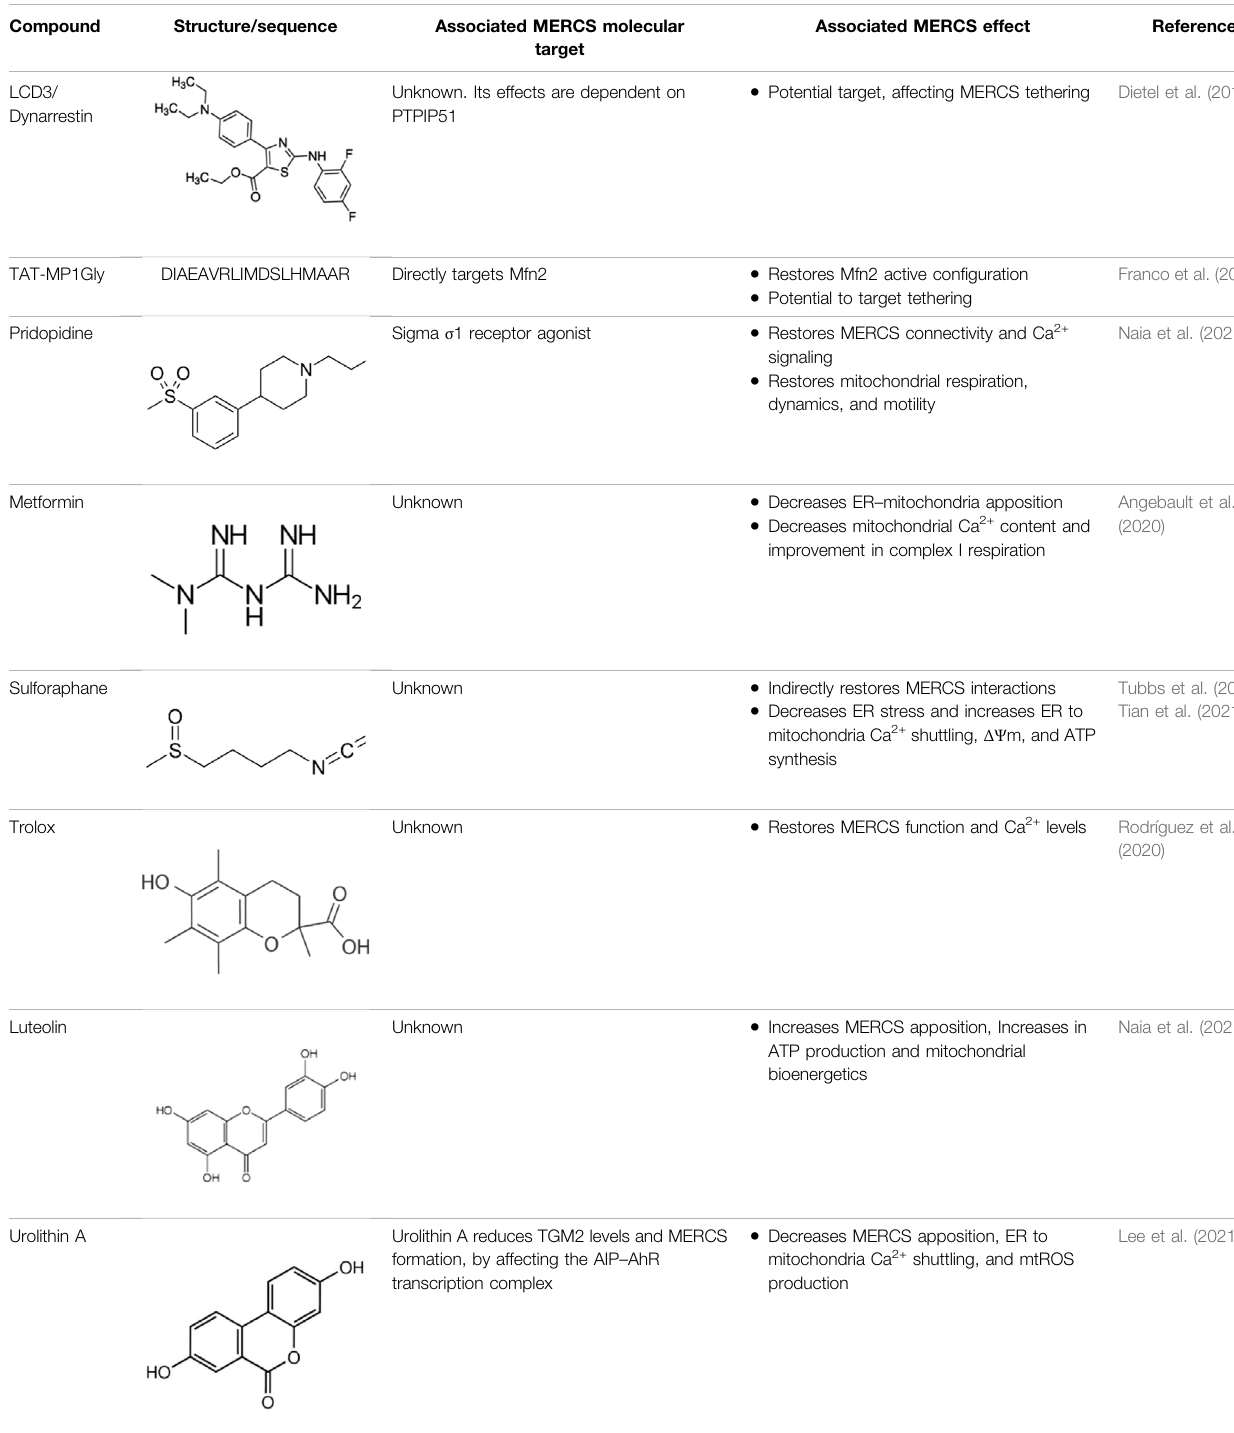
TABLE 1 | Examples of modulators targeting